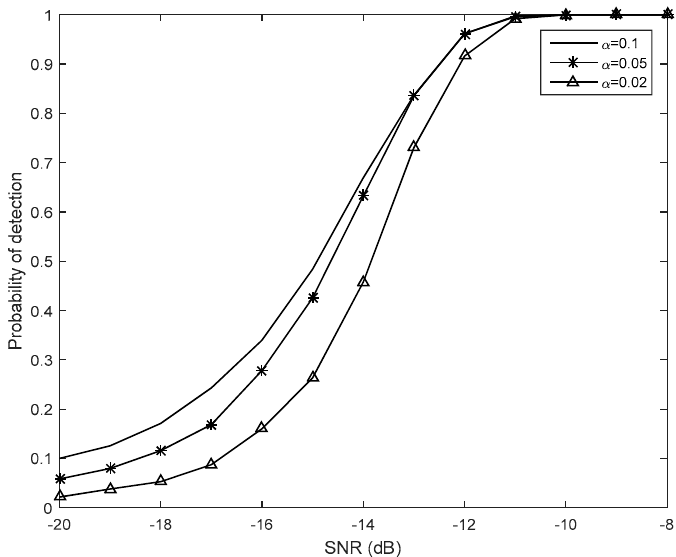
Figure 7. The probability of detection P d curves with a different given parameter α ( M = 10, N = 1000, P f = 0.01).